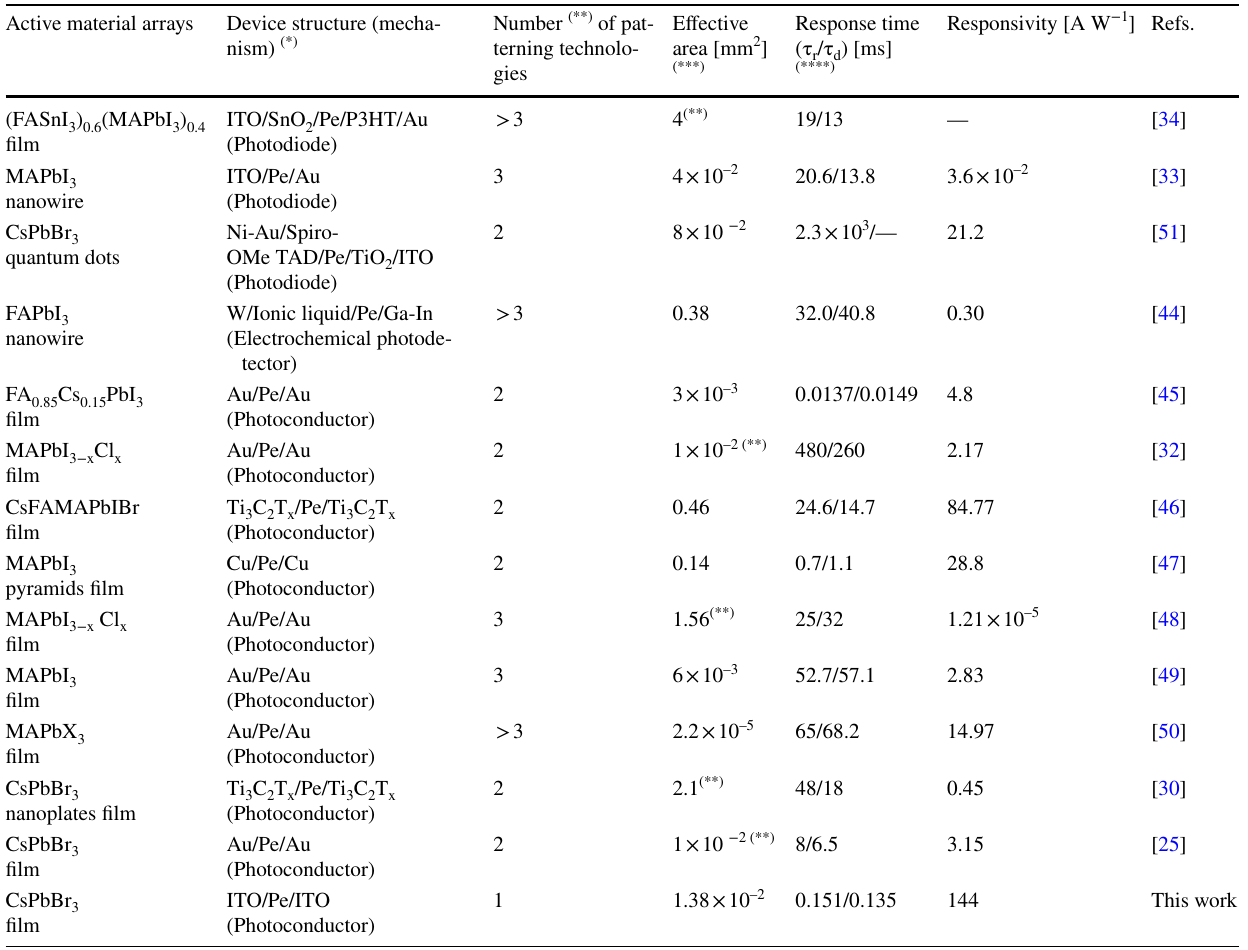
Table 1 Comparison of key parameters of SPR with reported arrayable photodetectors